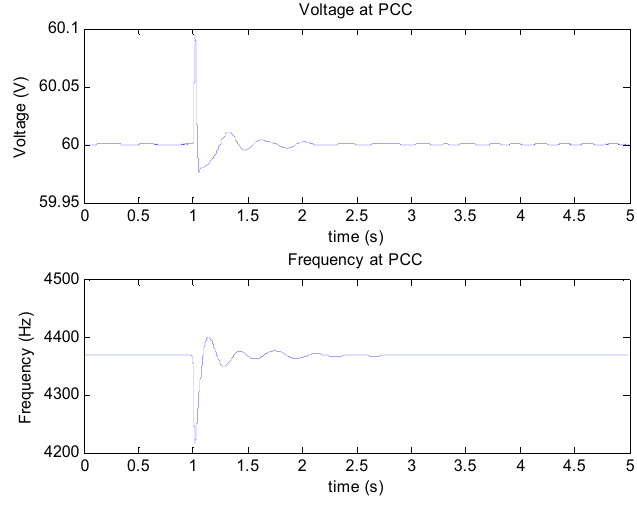
Figure 14. Reactive power sharing and active power sharing in Scenario II. Solid line, DG1; dash line, DG2; dash-dot line, DG3; dot line, DG4.